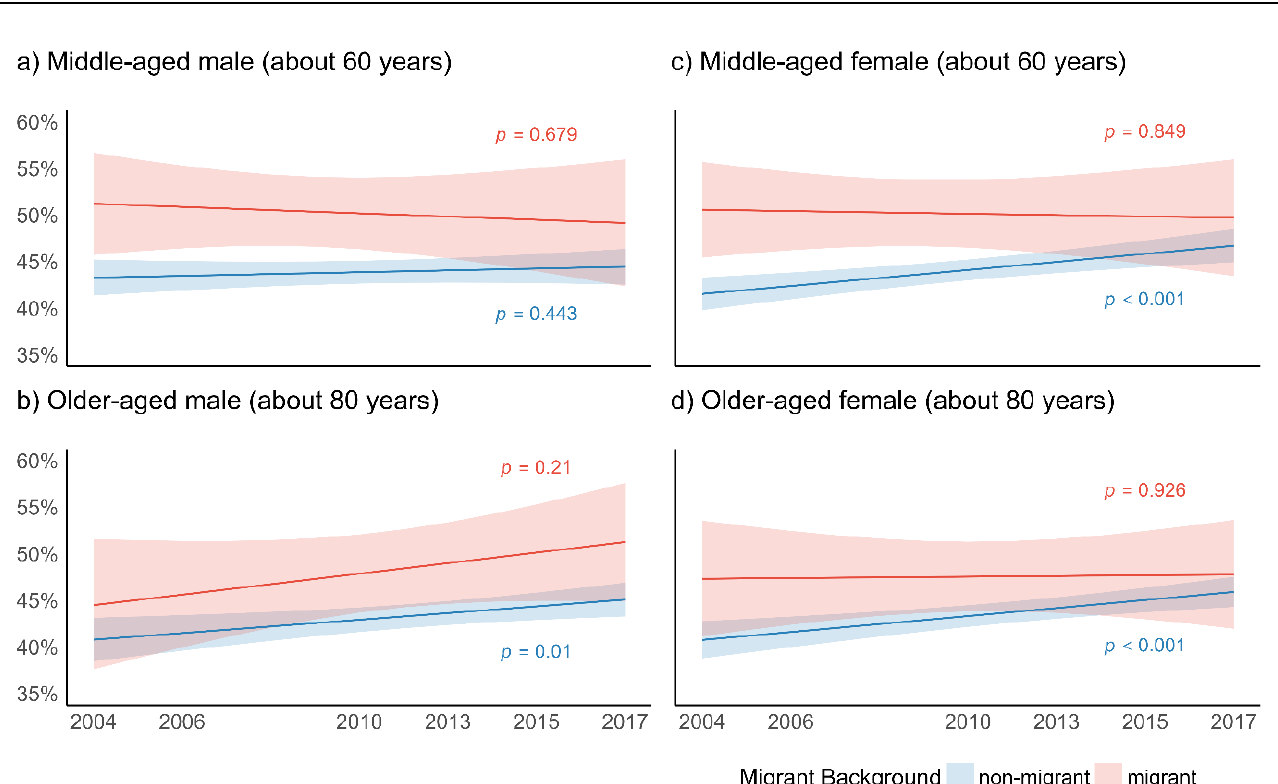
Figure 1. Predicted probabilities of Global Activity Limitation Index (% limited in daily activities) for migrant background, age, and gender (across six waves of SHARE); p -values relate to change over time for migrant and non-migrant elderly.